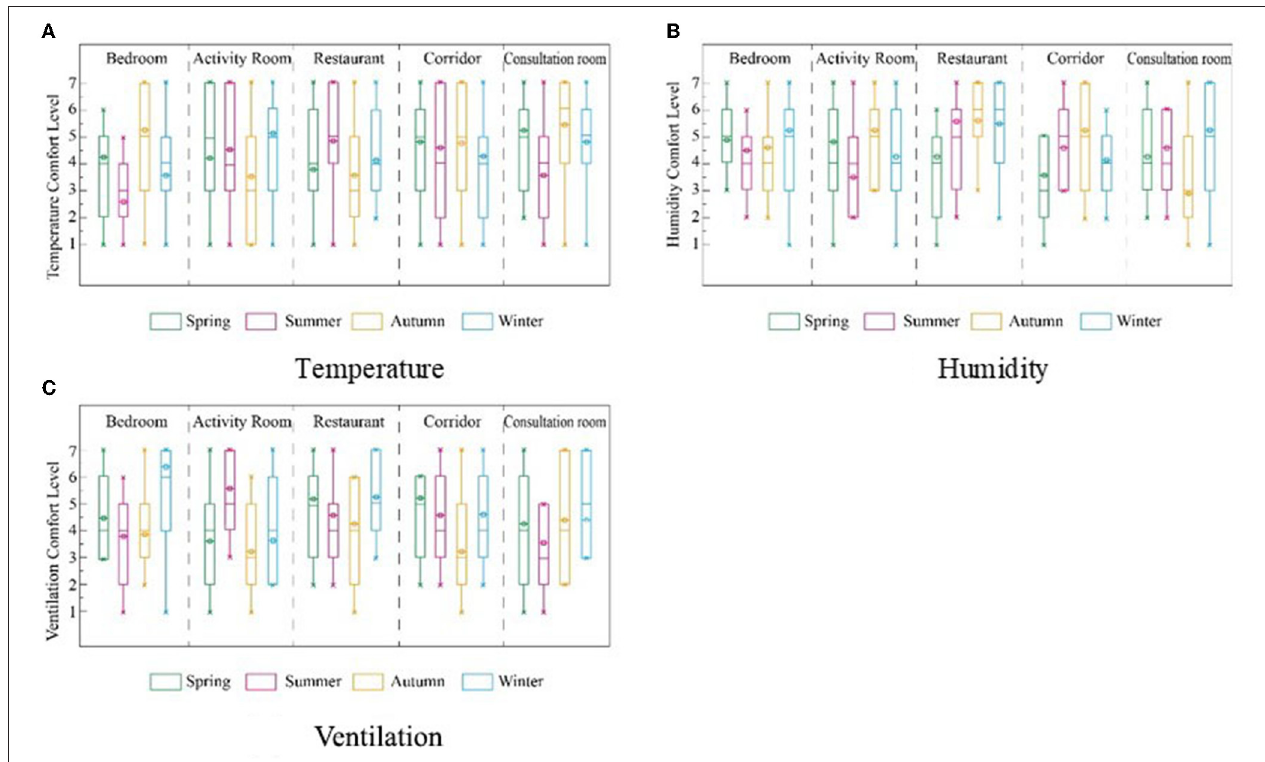
FIGURE 9 | Evaluation of thermal factors of 4 RECFs based on seasonal differences. (A) Temperature, (B) Humidity, and (C)